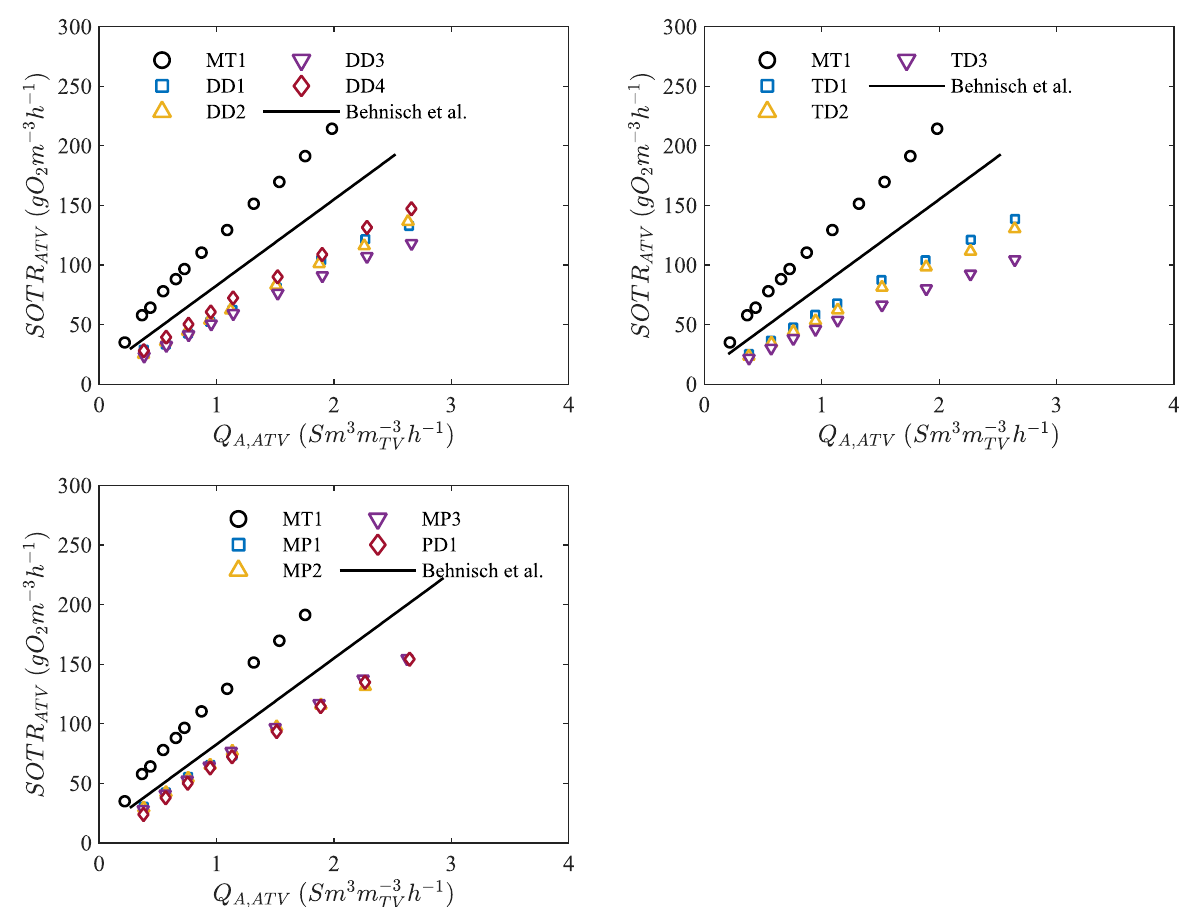
Figure 6. SOTR ATV vs. Q A,ATV for the tested diffusers as well as the results of micro-perforated plate and tube diffusers together with the literature [14].